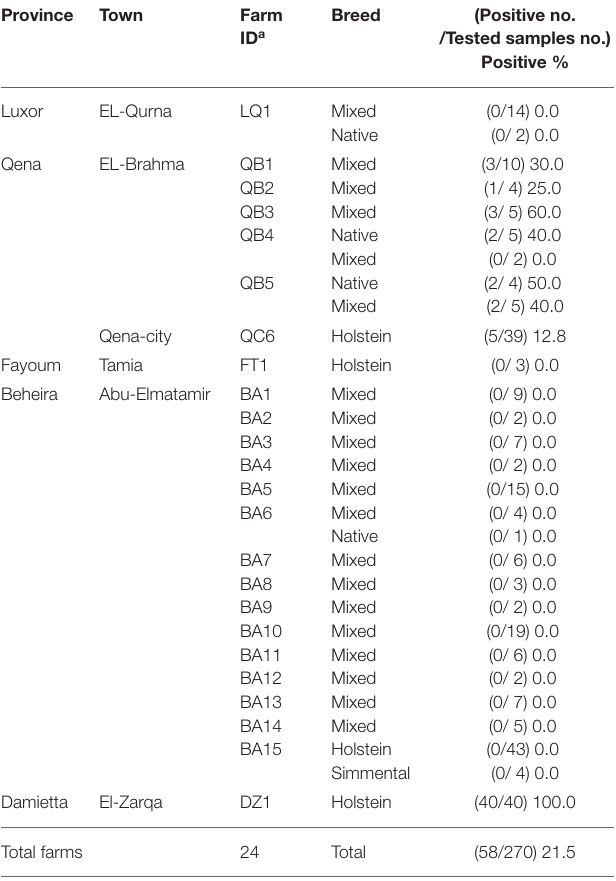
TABLE 1 | Detection of BLV infection in five provinces in Egypt as determined by CoCoMo-quantitative PCR (qPCR). Province (Positive no.